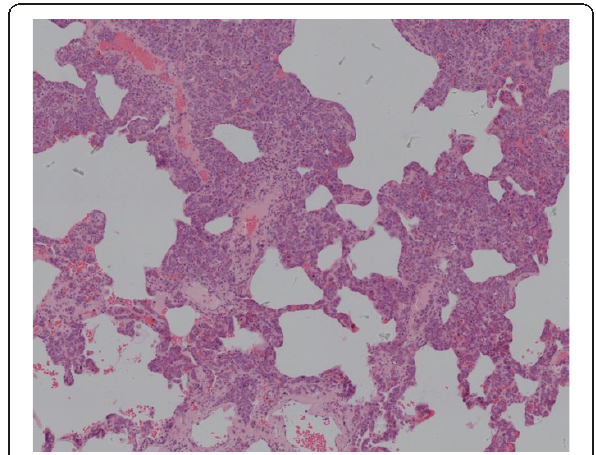
Figure 2 Hematoxylin-eosin staining of pulmonary interstitium intravascular lymphoma